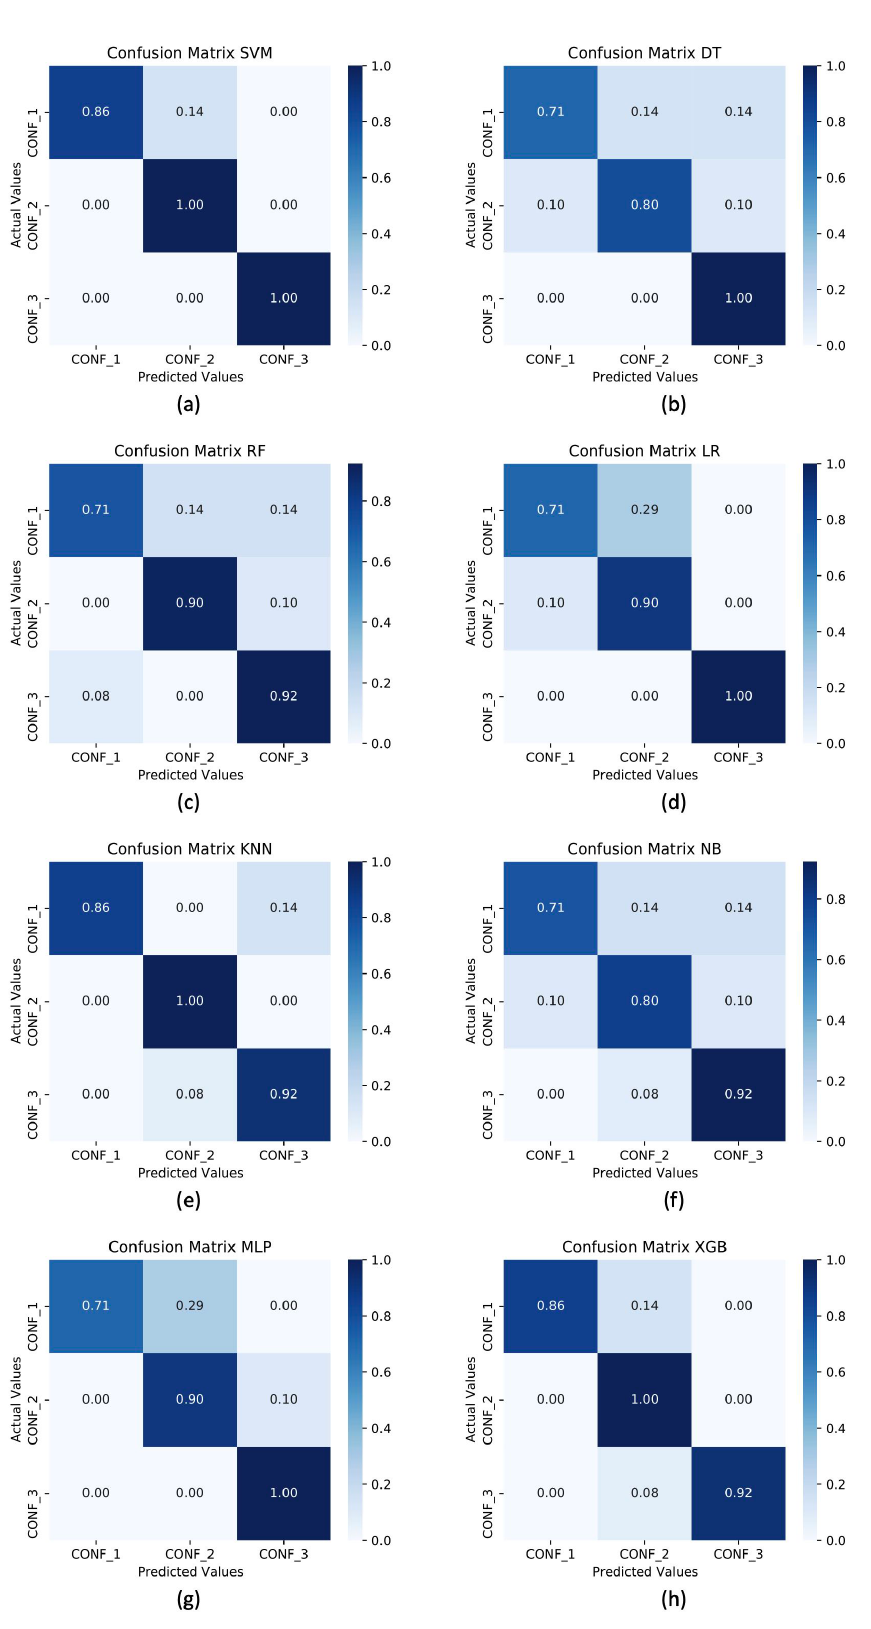
Figure 6. Confusion matrices for three classes of sarcopenia confidence levels using ( a ) SVM, ( b ) DT, ( c ) RF, ( d ) LR, ( e ) KNN, ( f ) NB, ( g ) MLP, ( h ) XGB as classifiers with feature